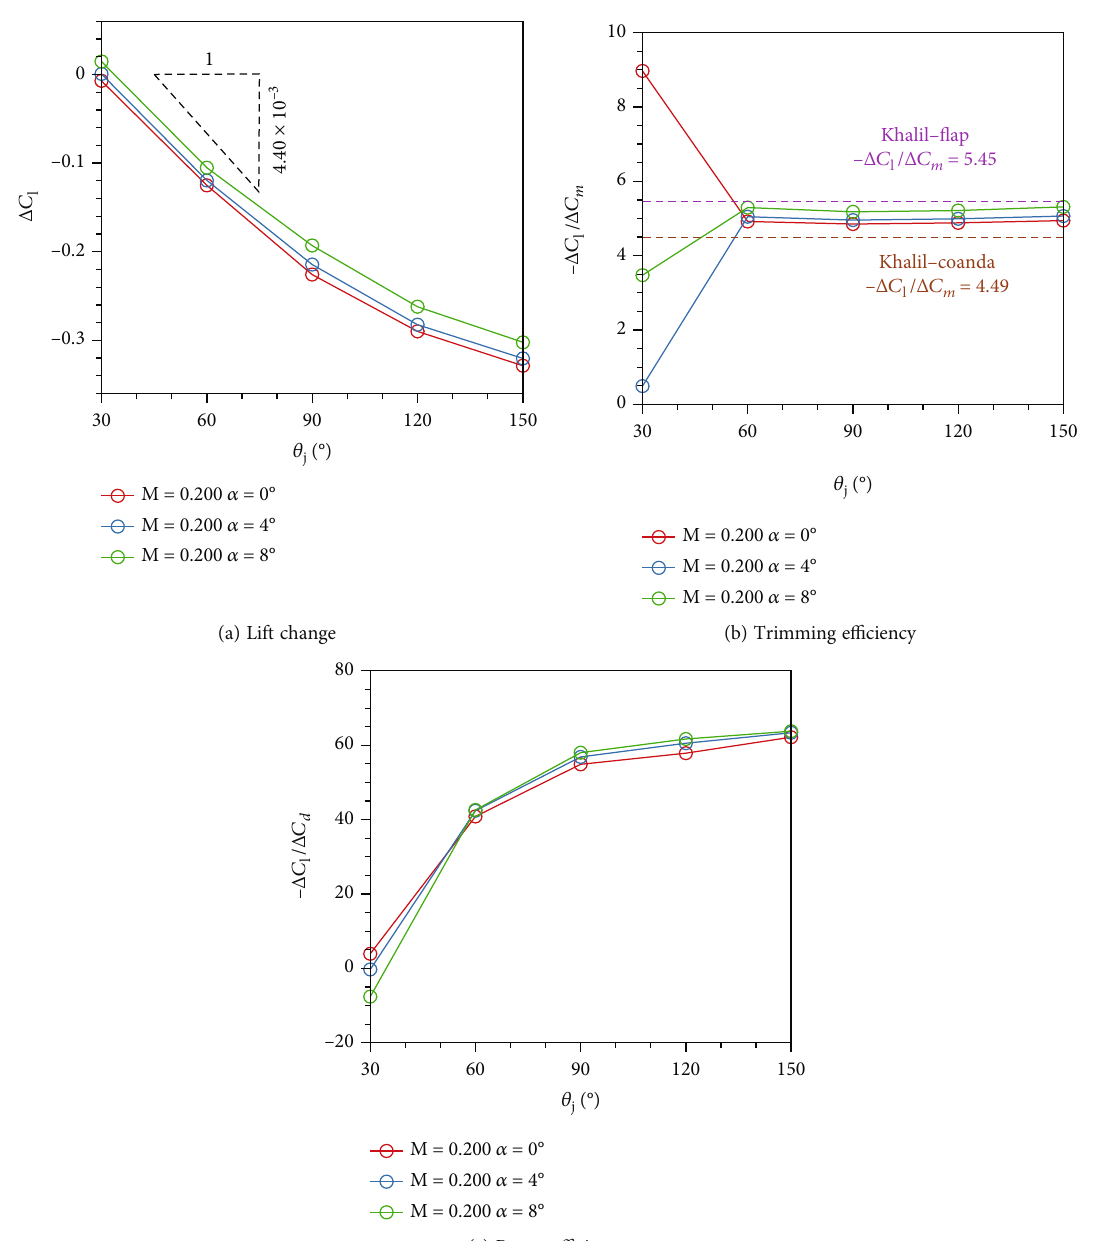
= 0 : 2 and C = 0 : 005 ∞ μ